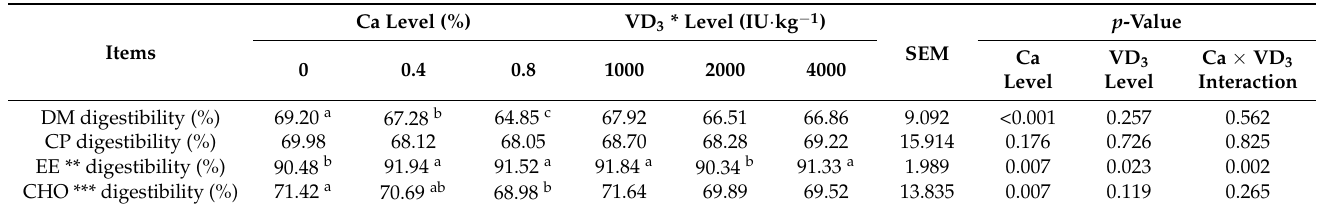
Table 3. The outcome of Ca and VD 3 diet supplementation on nutrient digestibility in maturing and furring blue